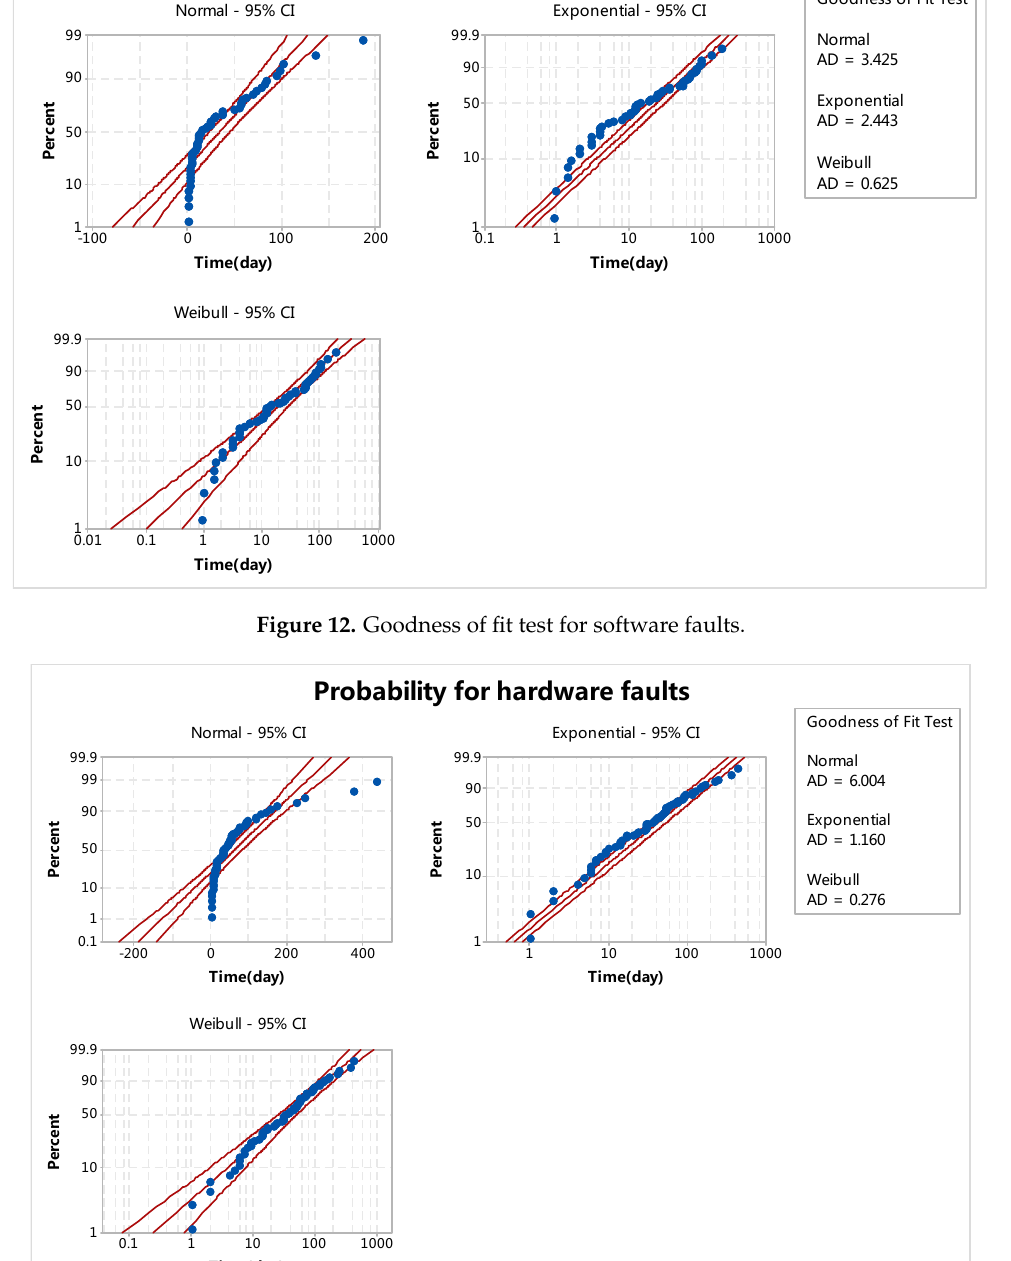
Figure 13. Goodness of fit test for hardware faults.